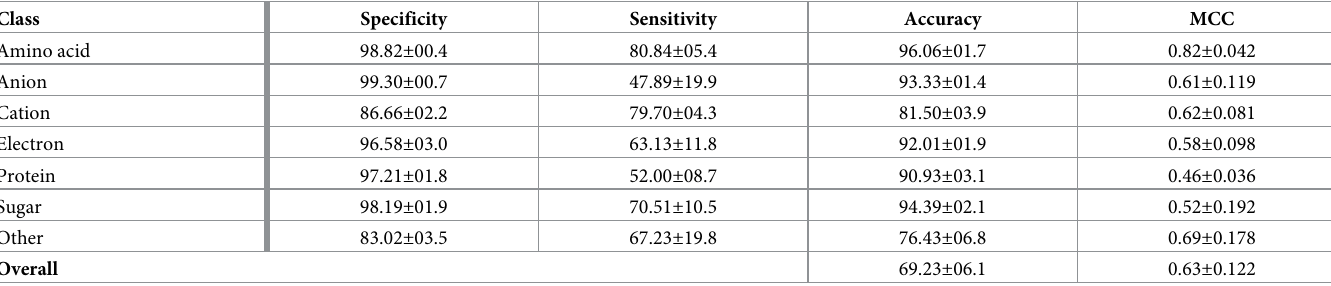
Fig 2. Performance of different methods. (a) MCC, (b) accuracy, (c) sensitivity, and (d) specificity. The dotted line represent the performance of TranCEP, which is TCS-TMC-PAAC. https://doi.org/10.1371/journal.pone.0227683.g002 The performance evaluation using LOOCV and independent testing prediction yielded similar patterns (available in S2 and S3 Files, respectively). A comparison of the results obtained by five-fold cross-validation, LOOCV, and the independent testing is presented in Fig 3. Table 3. Cross validation performance for